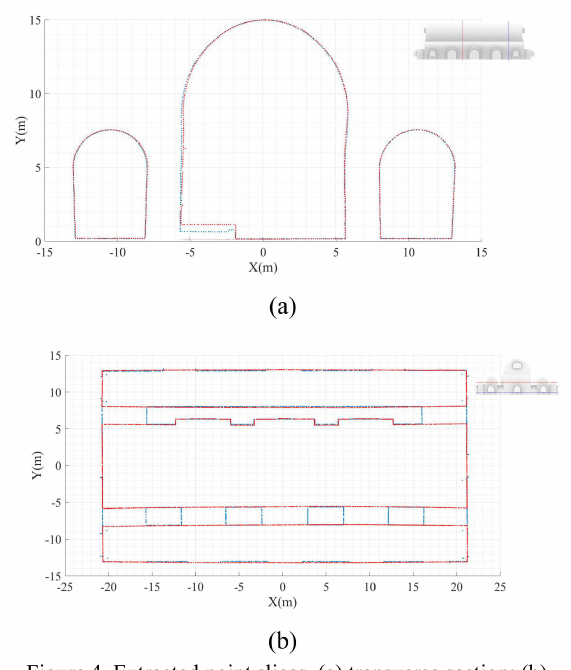
Figure 4. Extracted point slices. (a) transverse section; (b) floor